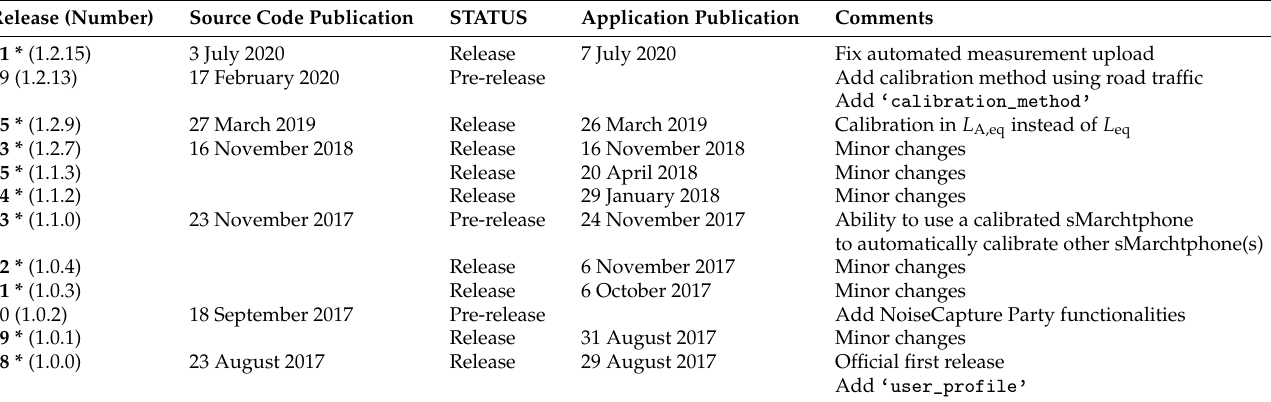
Table 1. NoiseCapture application releases. Each new version, defined by a version release (for example ‘51’) and a version number (for example ‘1.2.15’) proposes changes (bug corrections, user interface enhancement, etc.). The reader can refer to the detailed list of fixes in each (pre-)release from the GitHub source code management platform [27]. The changes made on the data export, from the smartphone to the data server (adding new data, patches, etc.), are detailed in the history of the source code file MeasurementExport.java [28]. The date of publication of the application on Google Play is also provided for information (corresponding official public release are indicated in bold with symbol